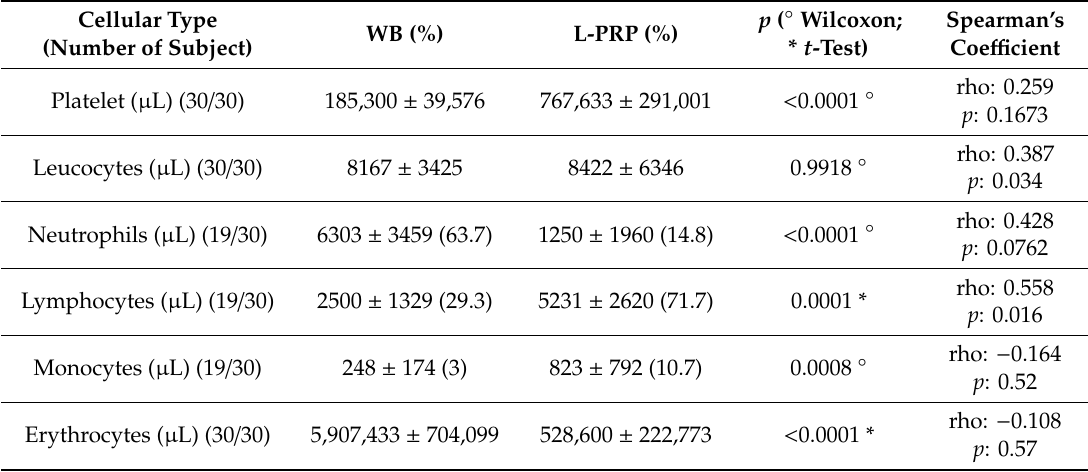
Table 1. Mean and standard deviation of whole blood (WB) and leukocyte-platelet rich plasma (L-PRP) cell